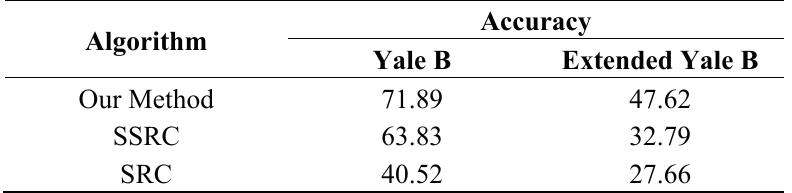
Table 5. Comparative recognition rates of our method and other recognition methods with three reference subjects in different datasets.